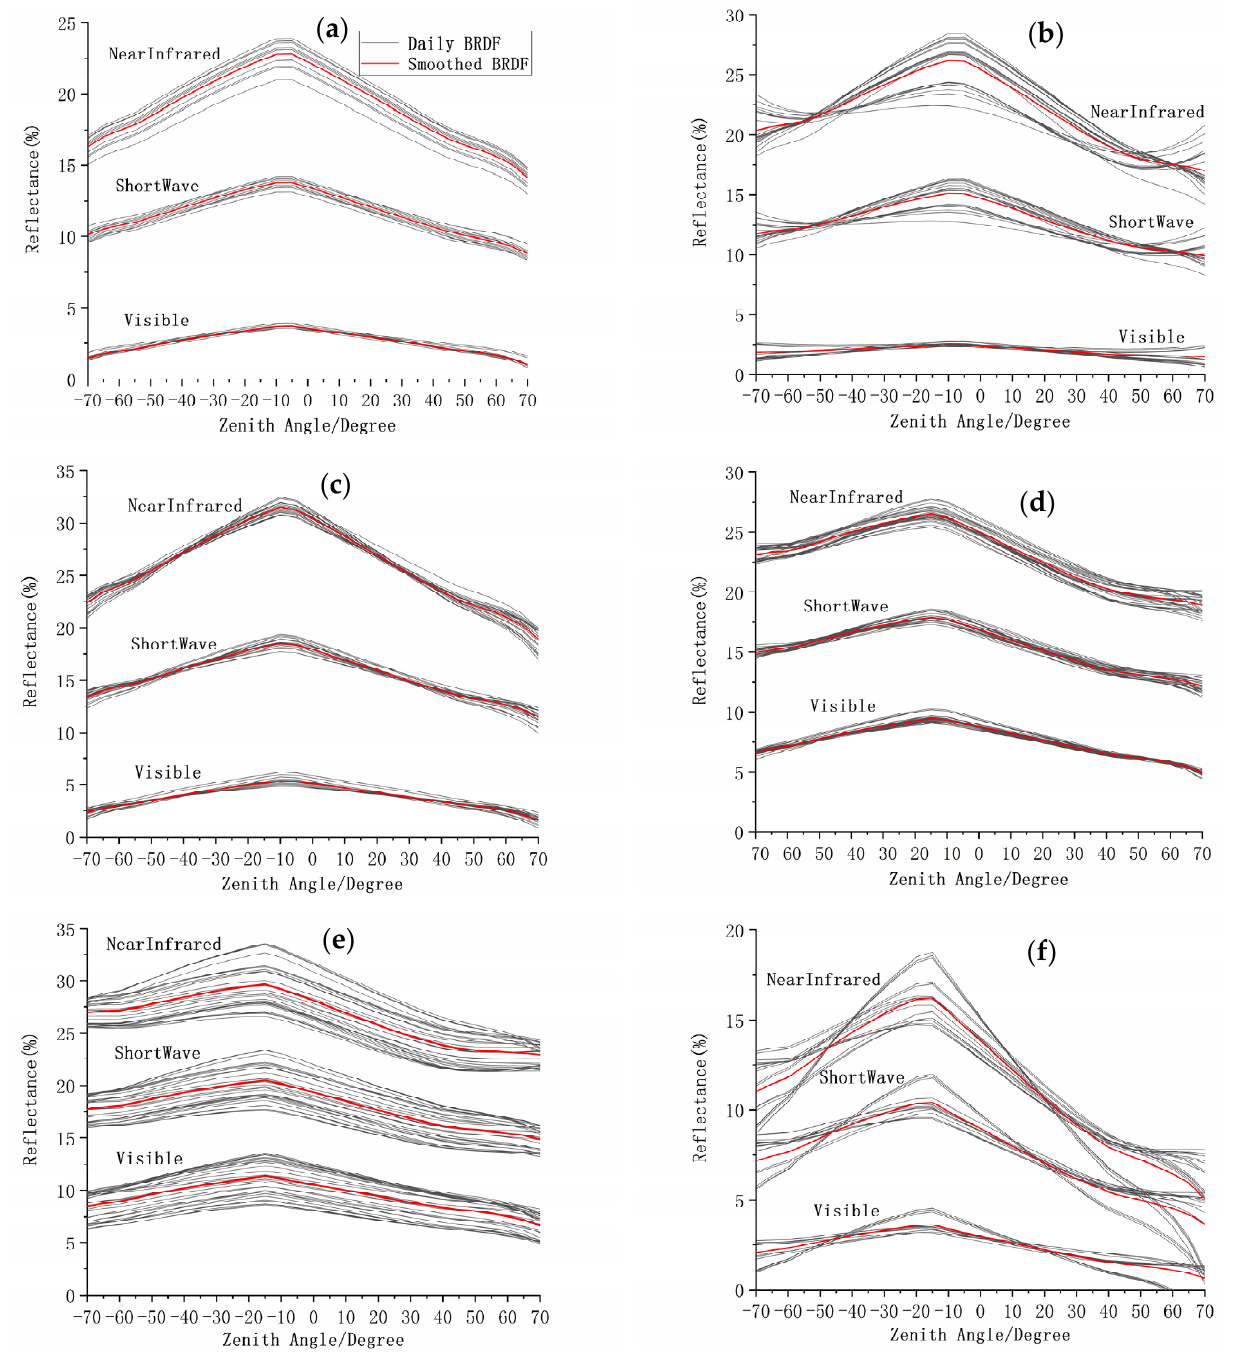
Figure 8. Comparison of smoothed BRDF in the principal plane with the daily retrievals over selected EBF ( a ), DBF ( b ), Savanna ( c ), Grassland ( d ), Cropland ( e ), and ENF ( f ) sites in June of 2019.